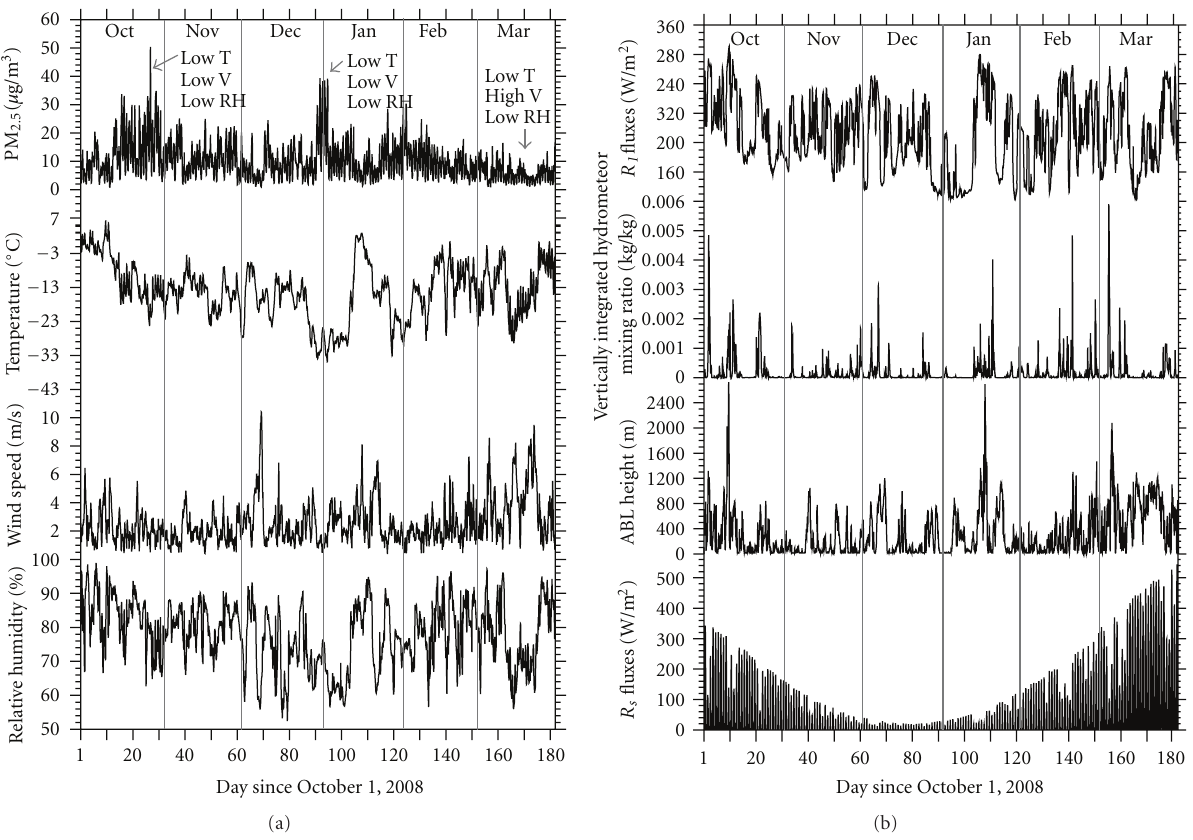
Figure 2: Temporal evolution of simulated hourly (a) PM 2 . 5 -concentration, temperature, wind-speed, relative humidity, and (b) downward long-wave radiation, hydrometeor mixing ratios, ABL-height and downward shortwave radiation averaged over the Fairbanks nonattainment area for each of the 182 simulation